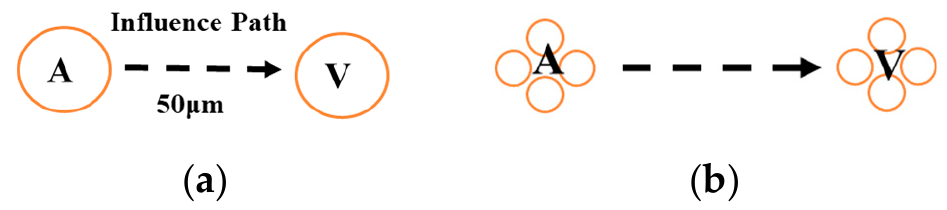
Figure 7. The influence path from aggressive TSV to victim TSV: A (Aggressive TSV), V (Victim TSV). ( a ) Two regular TSVs; ( b ) Two division